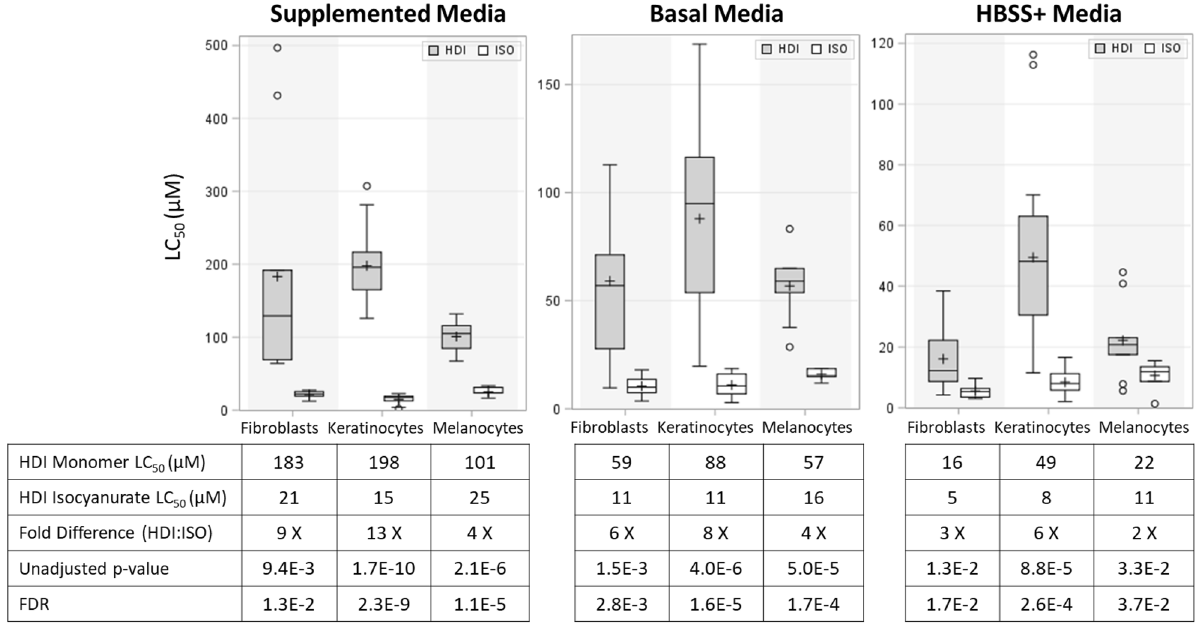
Figure 2. Box and whisker plots of toxicity as measured by the average concentration to kill 50% of the cells (LC 50 ) for HDI monomer (HDI)- and HDI isocyanurate (ISO)-treated cultures of keratinocytes, fibroblasts, and melanocytes. LC 50 values were determined using the CellTiter-Glo 2.0 ATP assay. Lower LC 50 values indicate greater toxicity. Note scale differences for the different media. Median LC 50 value (midline of the box), average LC 50 value (+), upper and lower quartile (edges of the box), highest and lowest LC 50 observations (whiskers), outlier LC 50 values (o).